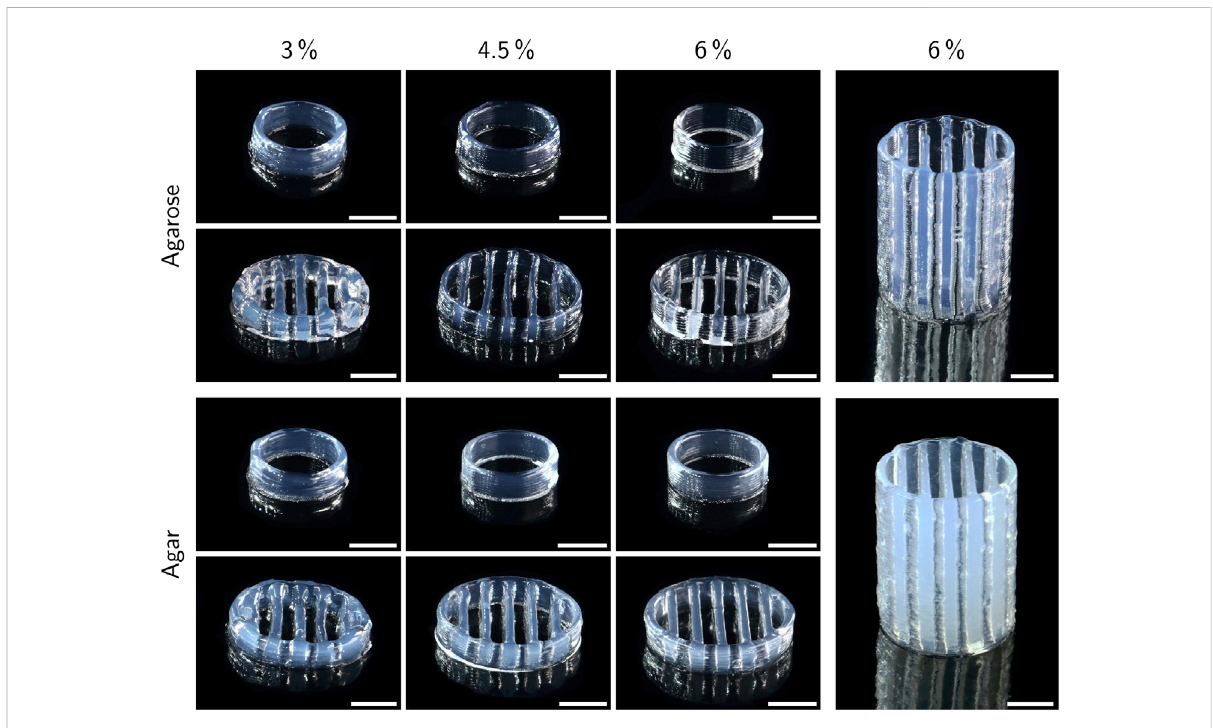
FIGURE 6 Exemplary prints of low-melt agarose and agar hydrogels with a target height of 3 mm (left side) and 20 mm (right side). All prints were carried out at a layer height of 300 µm. Scale bars represent 5